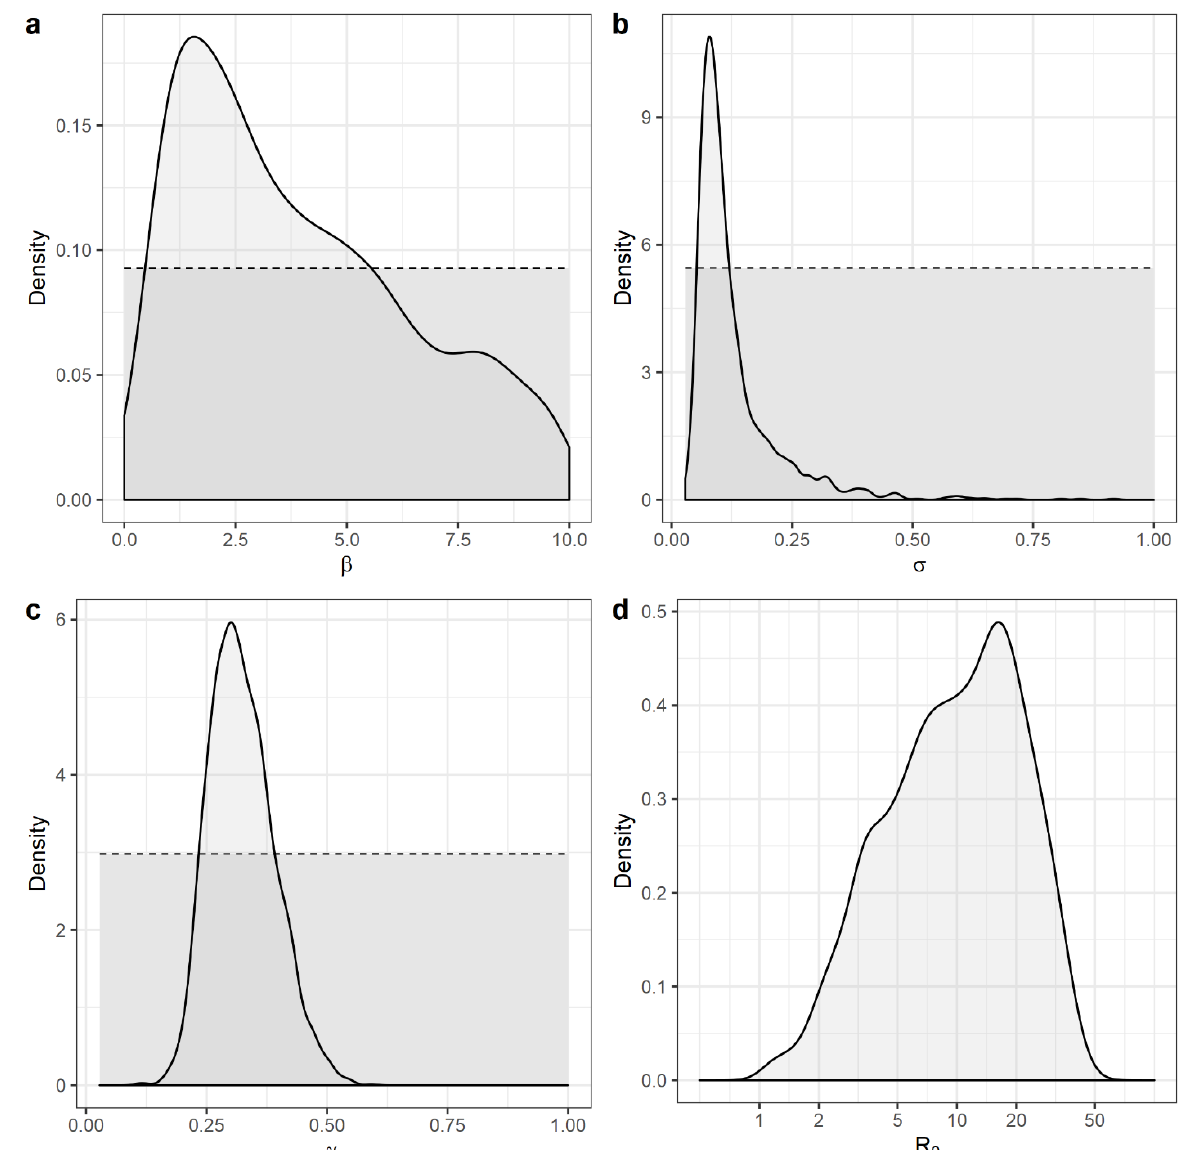
Figure 4. Prior (dashed lines) and posterior (solid lines) distributions for ( a ) the transmission coefficient β ; ( b ) the inverse of the average latent period σ ; ( c ) the inverse of the average duration of infectiousness γ ; ( d ) the basic reproductive number, R 0 which was a calculated output and (being a ratio) is presented on a logged horizontal axis.